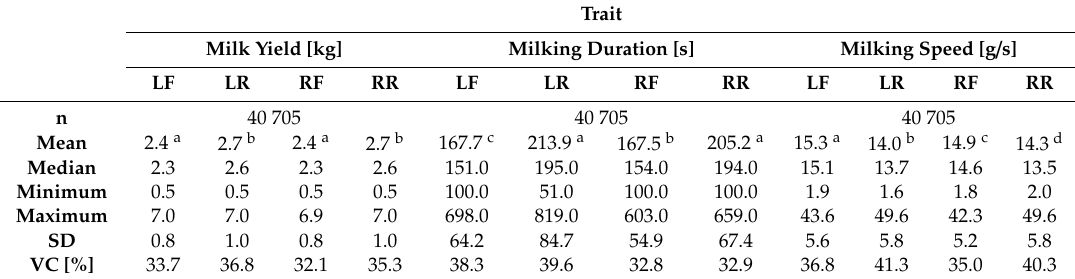
Table 2. Basic descriptive statistics of considered traits for single milkings from the left front (LF), left rear (LR), right front (RF) and right rear (RR) teats. Trait Milk Yield [kg] Milking Duration [s] Milking Speed [g /